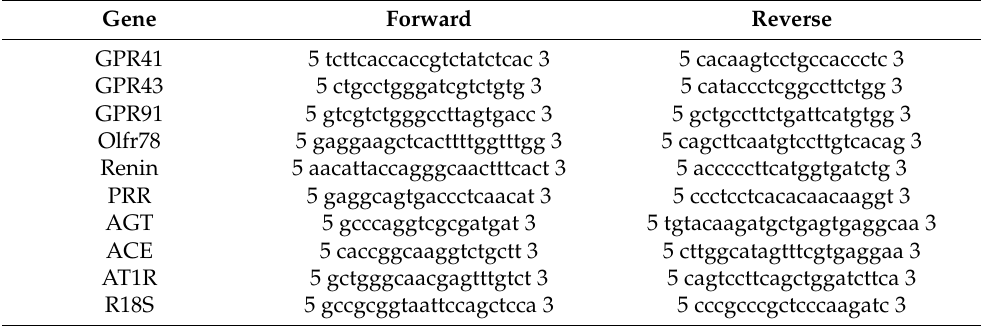
Table 4. PCR primer